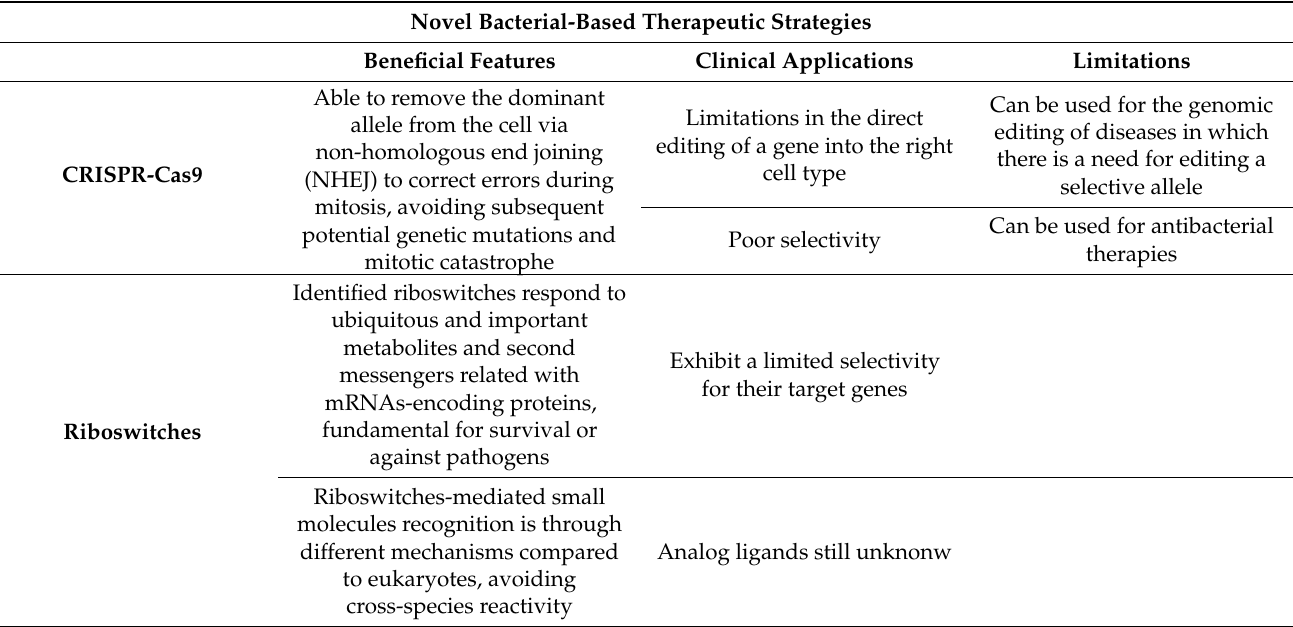
Table 1. CRISPR- Cas9 and riboswitches therapeutic applications and